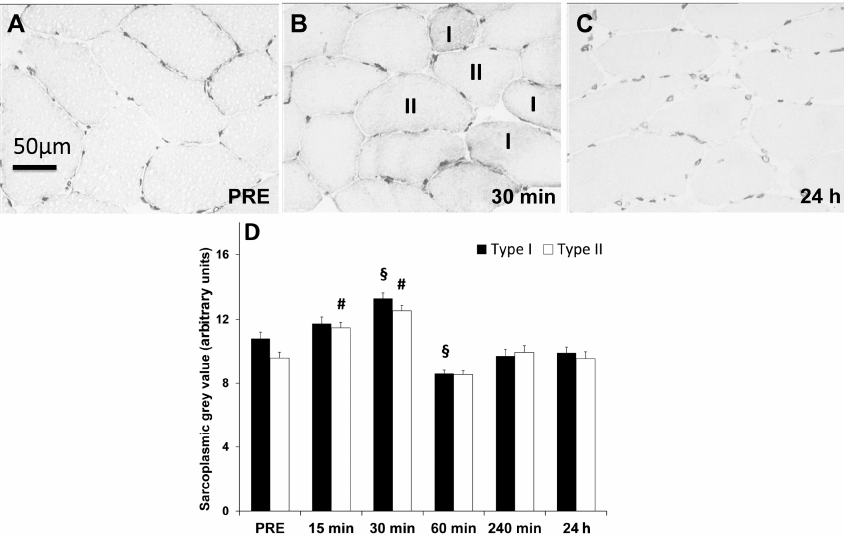
Figure 3. Changing sarcoplasmic SUMO-1 abundance within myofibres acutely and up to 24 h post resistance exercise. DAB-stained skeletal muscle cross-sections with changing sarcoplasmic SUMO-1 abundance after resistance exercise. ( A ) Skeletal muscle fibres displaying sarcoplasmic and nuclear SUMO-1 localization under resting conditions; ( B ) 30 min after cessation of RE with increased sarcoplasmic and nuclear density and ( C ) 24 h post RE displaying decreased sarcoplasmic and nuclear SUMO-1 localization; ( D ) Quantification of SUMO-1 abundance in sarcoplasmic compartments of type I and II myofibres over the time course of 24 h post RE. Values showing mean ± standard error of means (S.E.M.) arbitrary grey value units. Symbols: (§) time point significantly different ( p < 0.01) compared to PRE in type I myofibres; (#) time point significantly different ( p < 0.01) compared to PRE in type II myofibres; (horizontal bars) time point significantly different ( p < 0.01) between type I and II myofibres.